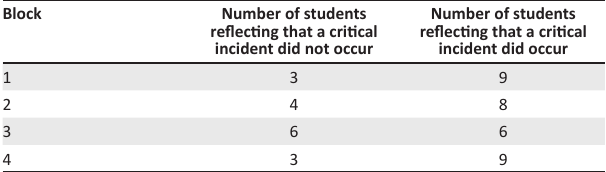
TABLE 1: Number of students reporting critical incidents per block.